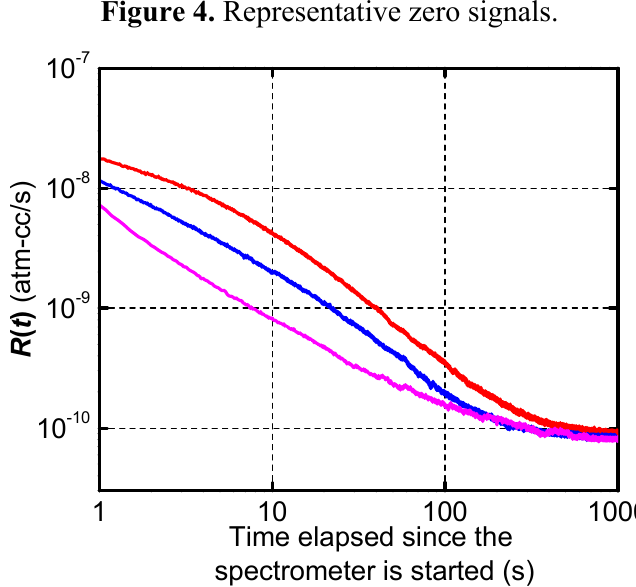
Figure 4. Representative zero